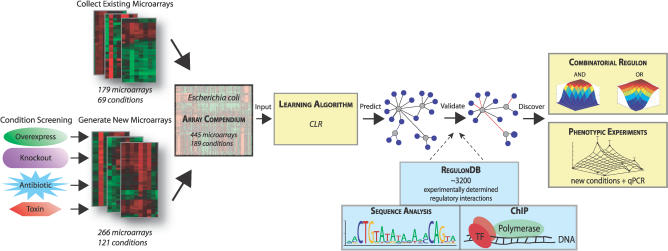
Overview of Our Approach for Mapping the E. coli Transcriptional Regulatory NetworkMicroarray expression profiles were obtained from several investigators. Our laboratory profiled additional conditions, focusing on DNA damage, stress responses, and persistence. These two data sources were combined into one uniformly normalized E. coli microarray compendium that was analyzed with the CLR network inference algorithm. The predicted regulatory network was validated using RegulonDB, sequence analysis, and ChIP. The validated network was then examined for cases of combinatorial regulation, one of which was explored with follow-up real-time quantitative PCR experiments.